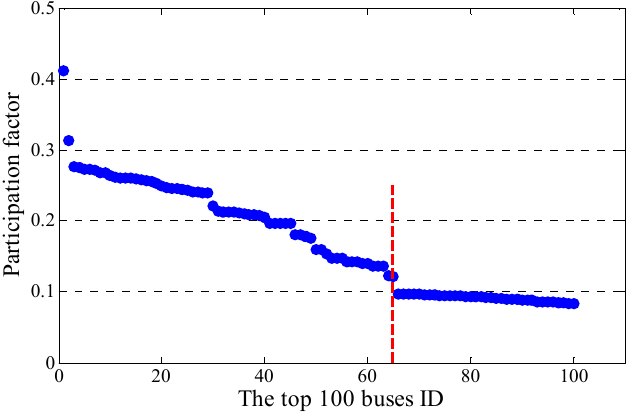
Figure 3. Participation factors (PFs) of the top 100 buses.